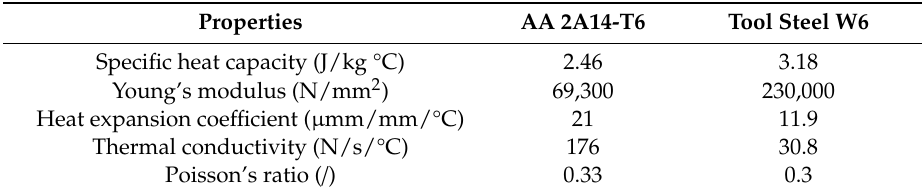
Table 1. Thermal characteristics of the 2A14-T6 workpiece and W6 tool.